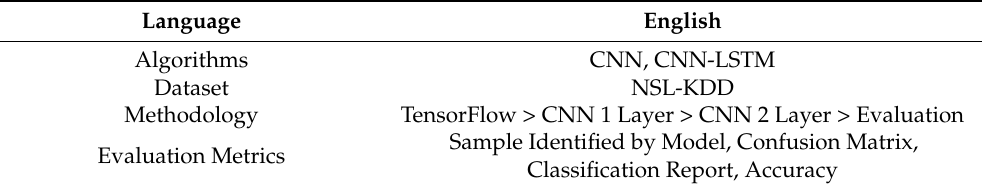
Table 3. Summary of results.